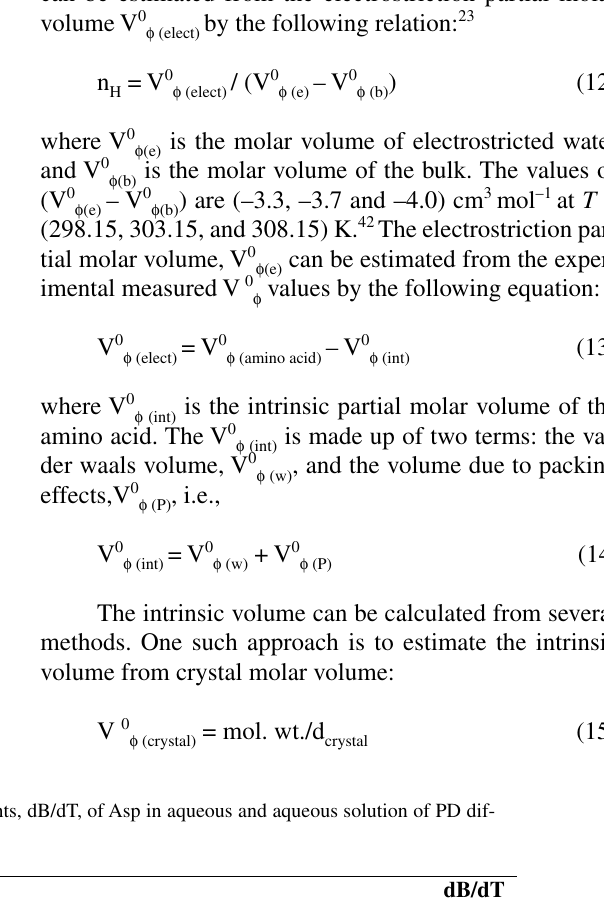
Table 8. Viscosity B-coefficients and temperature coefficients, dB/dT, of Asp in aqueous and aqueous solution of PD dif- ferent temperatures. System